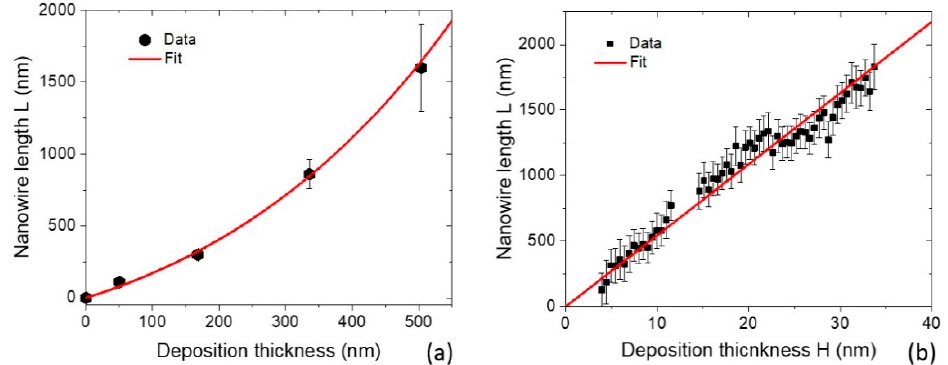
Figure 4. Evolution of the NW length with deposition thickness for ( a ) Au-catalyzed GaAs NWs grown by MBE on the unpatterned GaAs(111)B substrate [21], and ( b ) individual Ga-catalyzed GaAs NW grown by MBE on the patterned Si(111) substrate [38]. The length evolution is exponential in ( a ) and linear in ( b ).